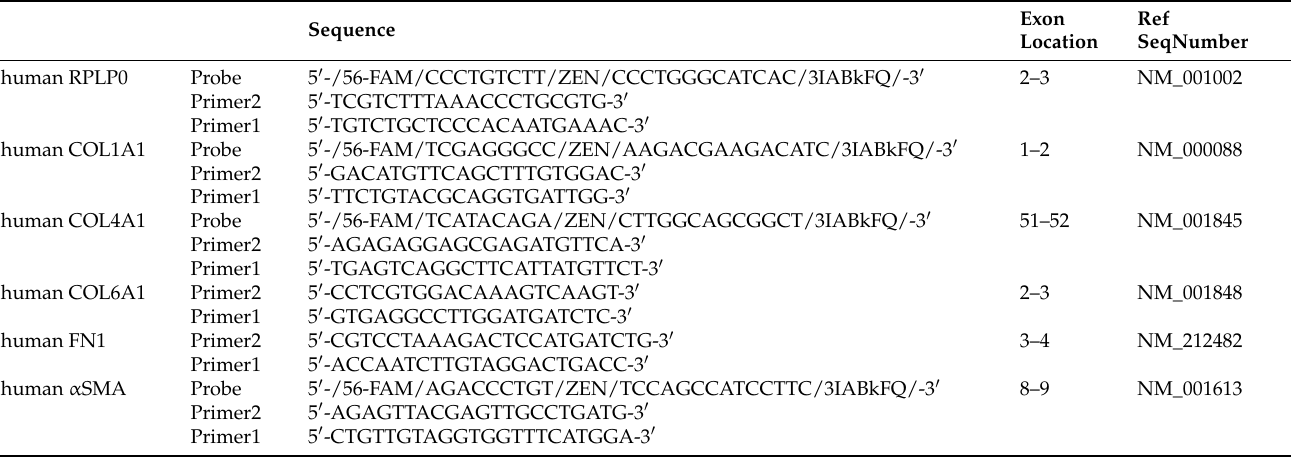
Table 1. The sequences of primers and the Taqman